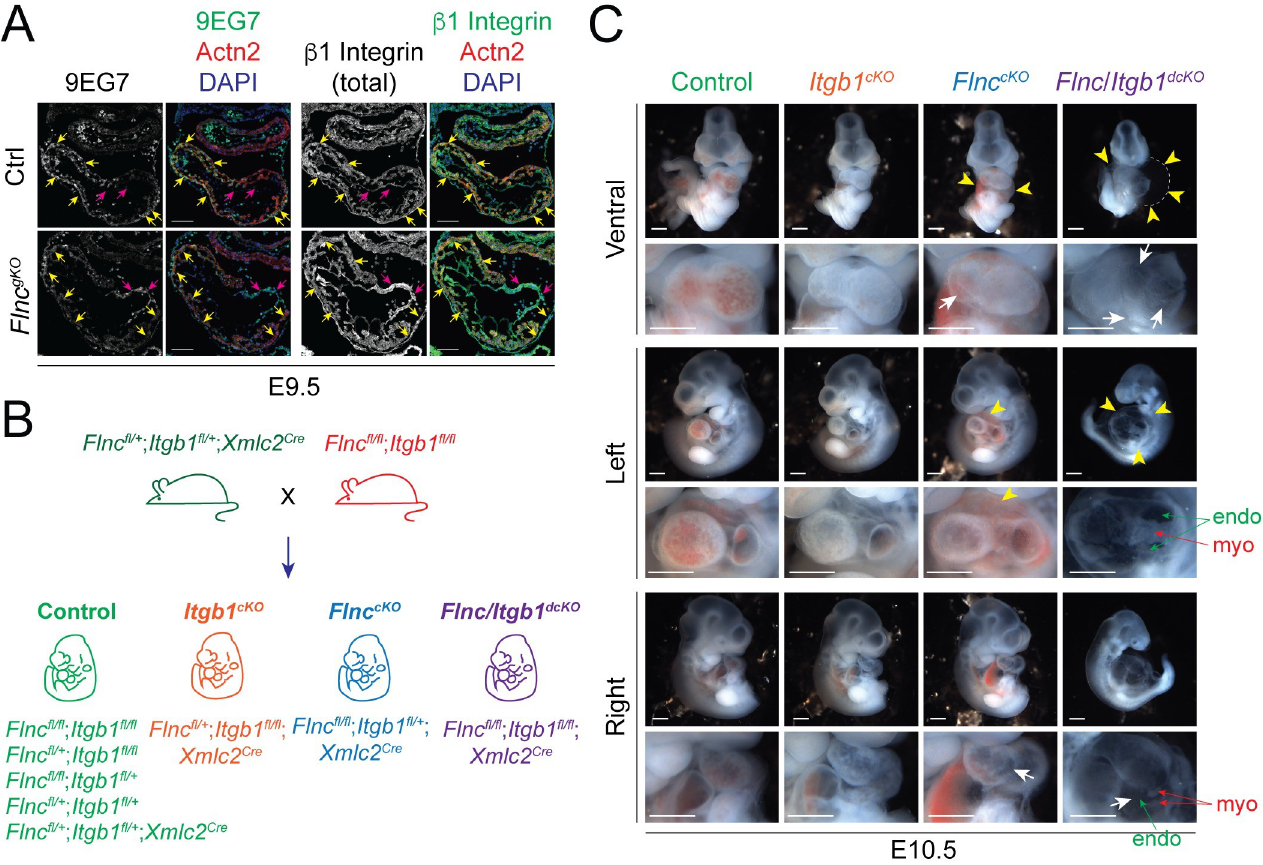
Fig 5. Both filamin C and β 1 integrin is required to maintain the structural integrity of myocardium. ( A ) Representative activated (9EG7) and total β 1 integrin immunofluorescence images of control and Flnc gKO hearts at E9.5. yellow arrows: myocardium; magenta arrows: endocardium. Scale bar, 0.1 mm. ( B ) The strategy for generating cardiomyocyte-specific Itgb1 knockout mice ( Itgb1 cKO ), cardiomyocyte-specific Flnc knockout mice ( Flnc cKO ) and cardiomyocyte- specific Flnc/Itgb1 double knockout mice ( Flnc/Itgb1 dcKO ). ( C ) Wholemount images of control, Itgb1 cKO , Flnc cKO and Flnc/Itgb1 dcKO embryos at E10.5. Yellow arrowheads indicate pericardial effusion; White arrows indicate heart ruptures. Scale bar, 0.5